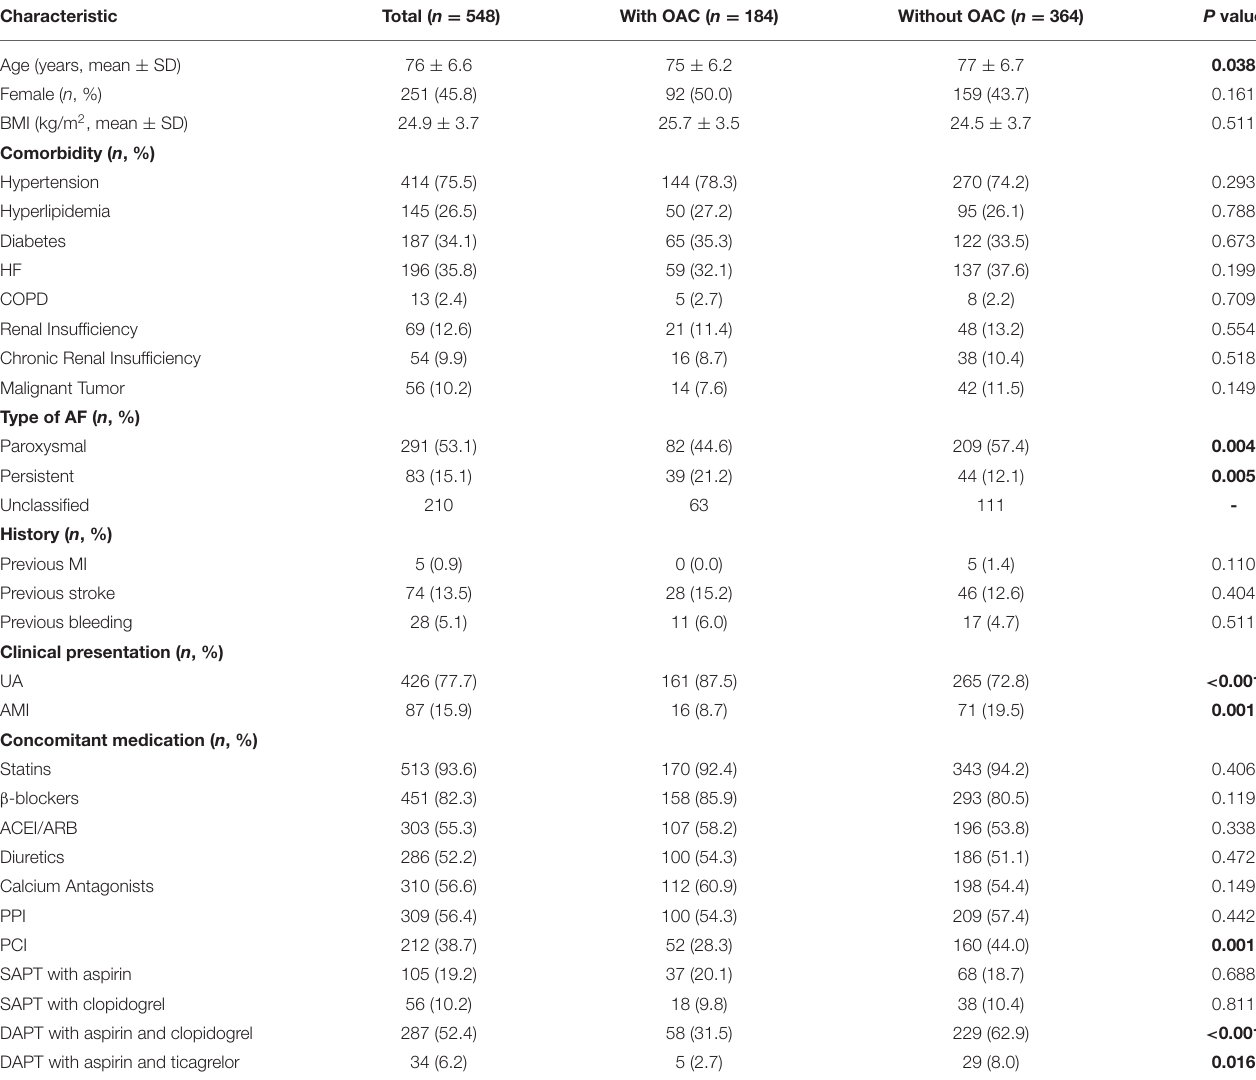
TABLE 1 | Clinical baseline characteristics according to with or without OAC treatment. Characteristic Total ( n = 548) With OAC ( n =